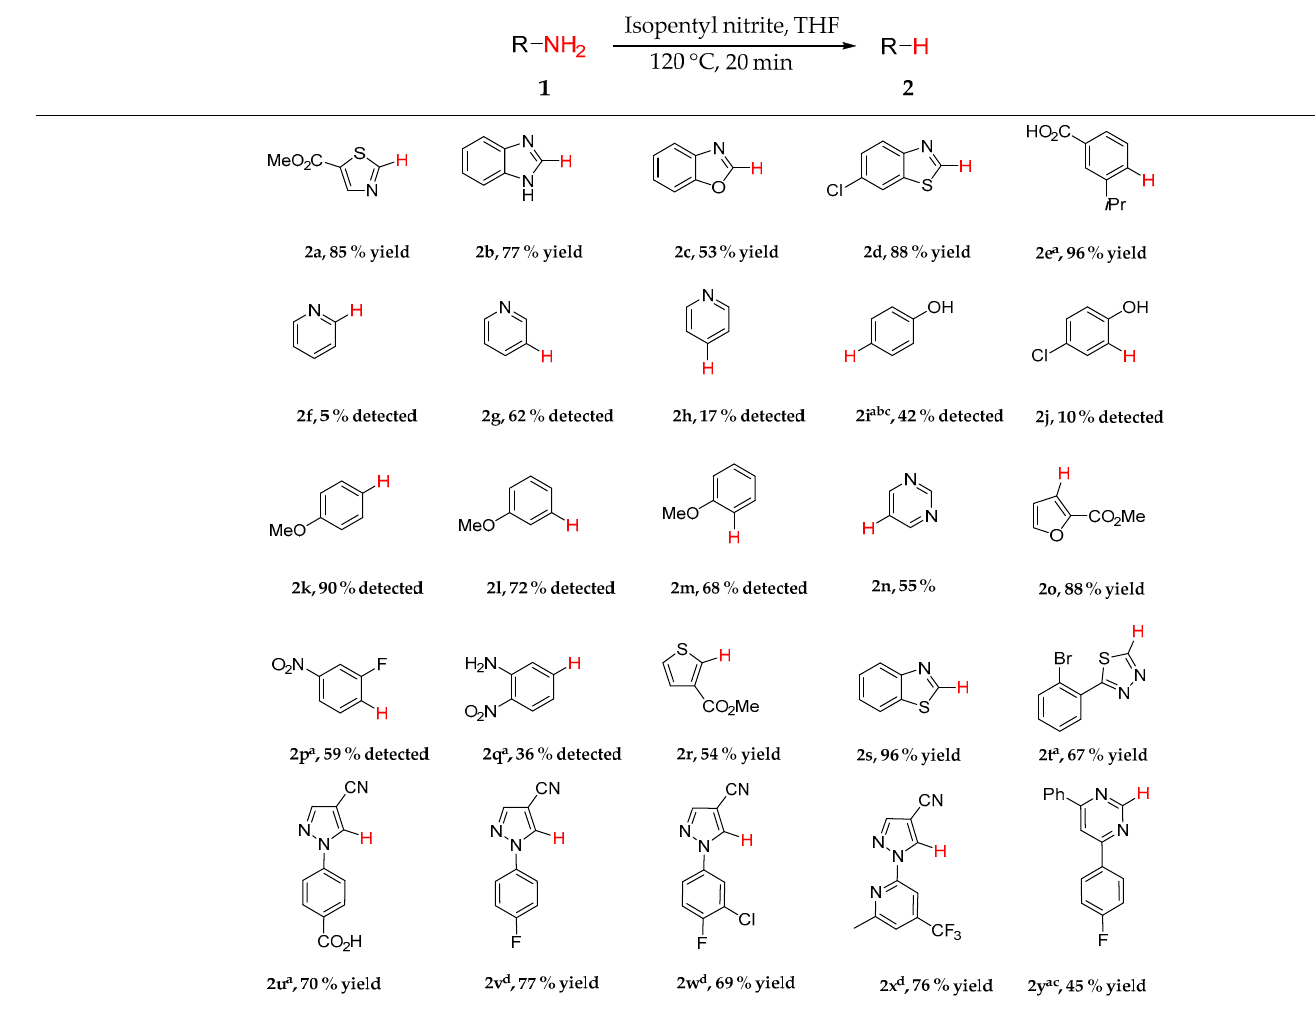
Table 6. Flow hydrodediazoniation of aromatic amines.